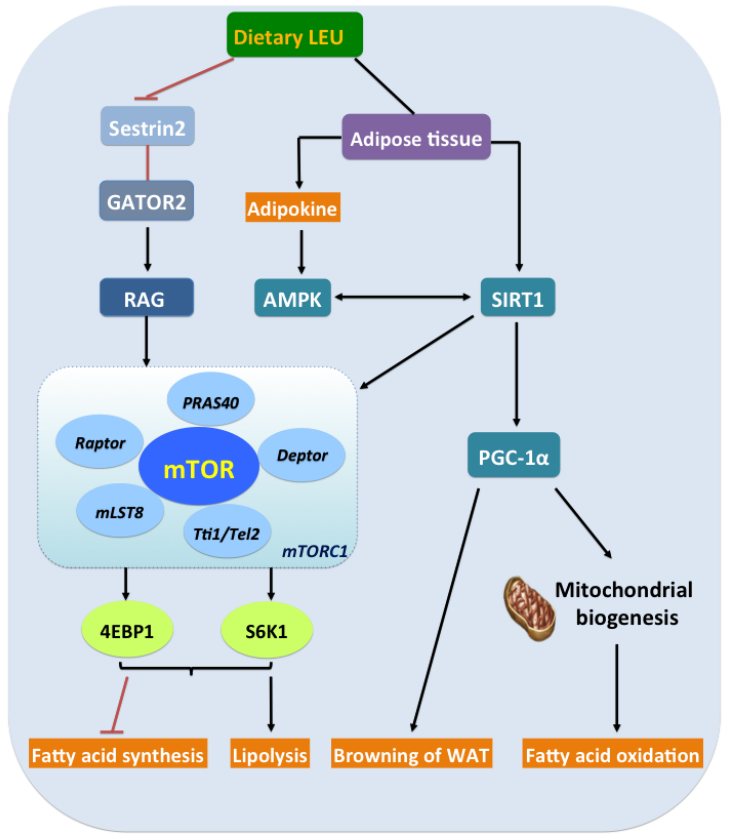
Figure 2. Dietary leucine effects on lipid metabolism in adipose tissues. After ingestion, leucine binds to Sestrin2, and then activates mammalian target of rapamycin complex 1 (mTORC1), facilitates lipolysis, and inhibits fatty acid synthesis by modulating the substrates such as translational inhibitor 4E-binding protein-1 (4EBP1) and S6 kinase 1 (S6K1). It also regulates adipokine synthesis/secretion and adenosine 5‘-monophosphate-activated protein kinase (AMPK)–silent information regulator of transcription 1 (SIRT1)–proliferator-activated receptor γ coactivator-1α (PGC-1α) energy axis in adipose tissue, thus modulating mitochondrial biogenesis, promoting browning and fatty acid oxidation.